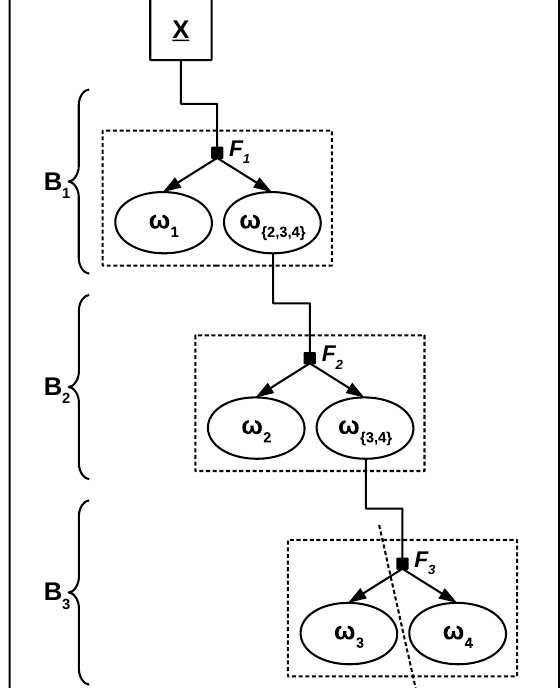
Figure 2. Decision-tree classification for a four-class problem. A feature vector x is assigned to one of the four classes ω j after a maximum of three binary decisions, using separate feature sets F i for each individual